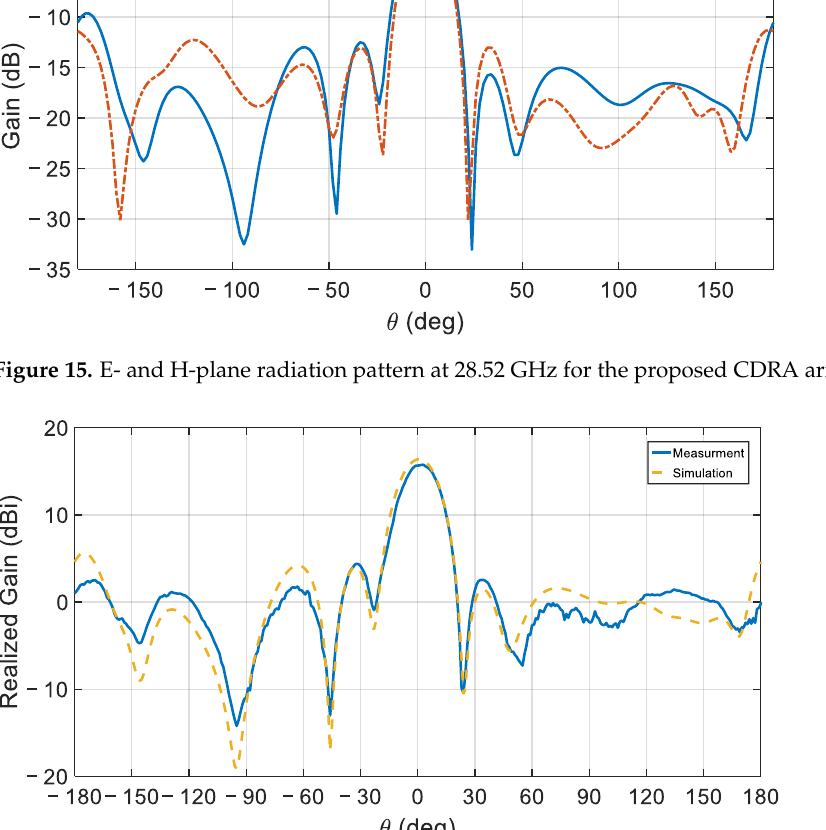
Figure 16. The simulated and measured radiation pattern of the CDRA array at 28.72 GHz.